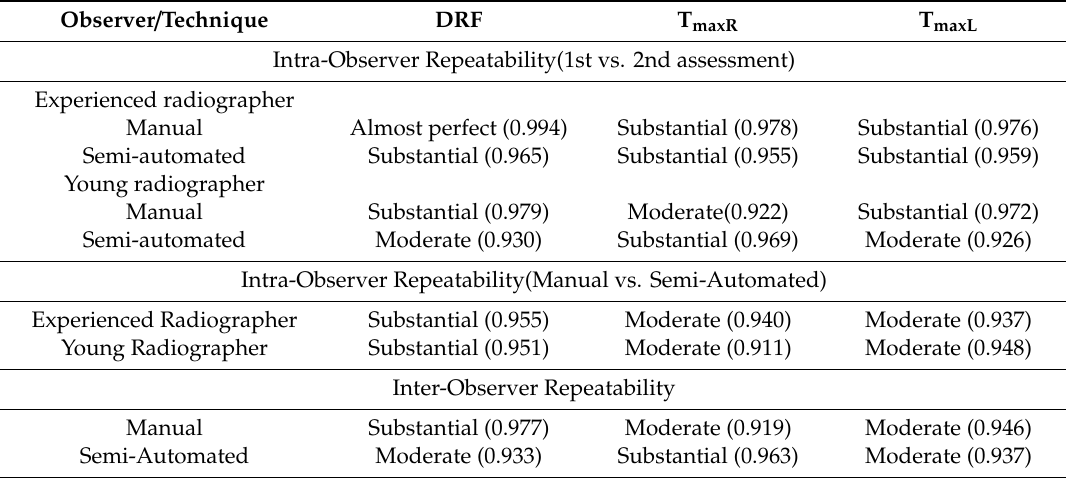
Table 6. Intra- and inter-observer repeatability analysis based on Lin’s concordance correlation coe ffi cient (CCC).